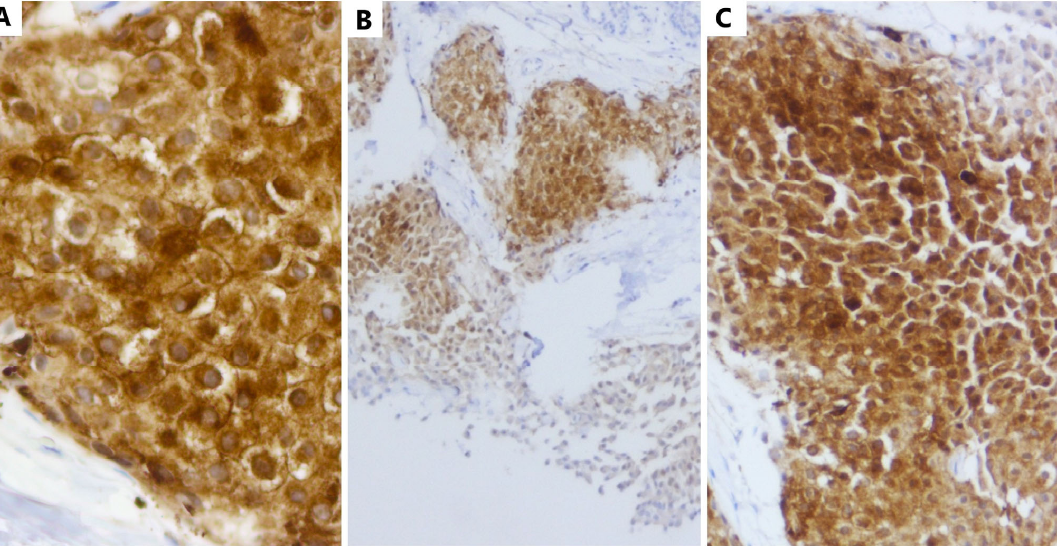
Figure 2. Neuroendocrine tumor of the breast: ( A ) NSE antibody (strong expression, ob.40×); ( B ) Chromogranin A antibody (strong and diffuse expression, ob.10 × ); ( C ) Synaptophysine antibody (strong expression, ob.20×).